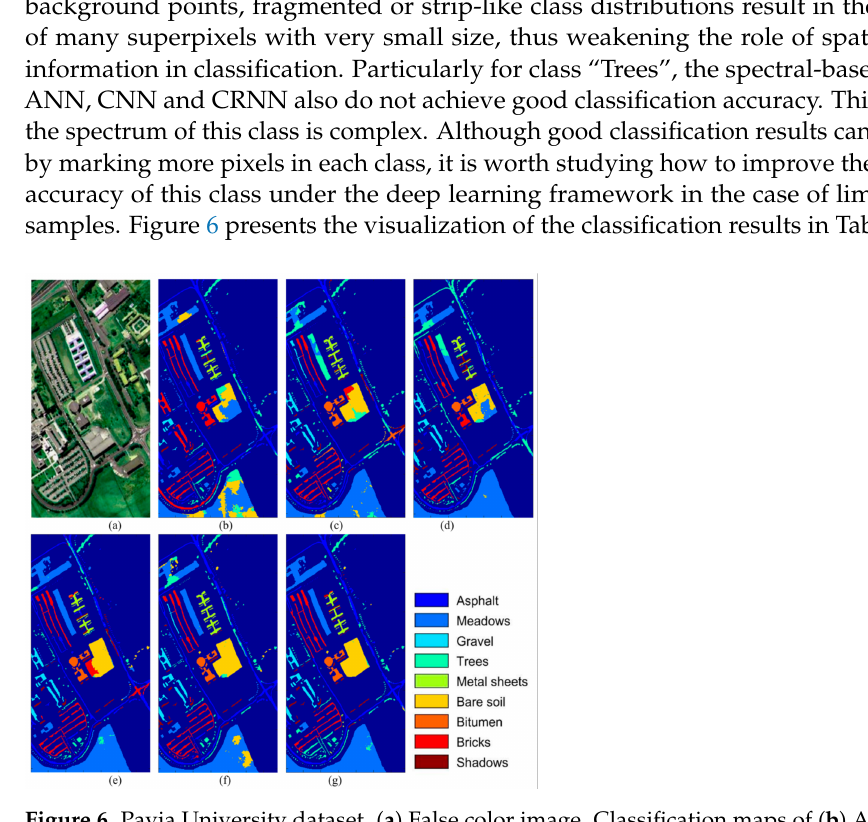
Figure 6. Pavia University dataset. ( a ) False color image. Classification maps of ( b ) ANN, ( c )